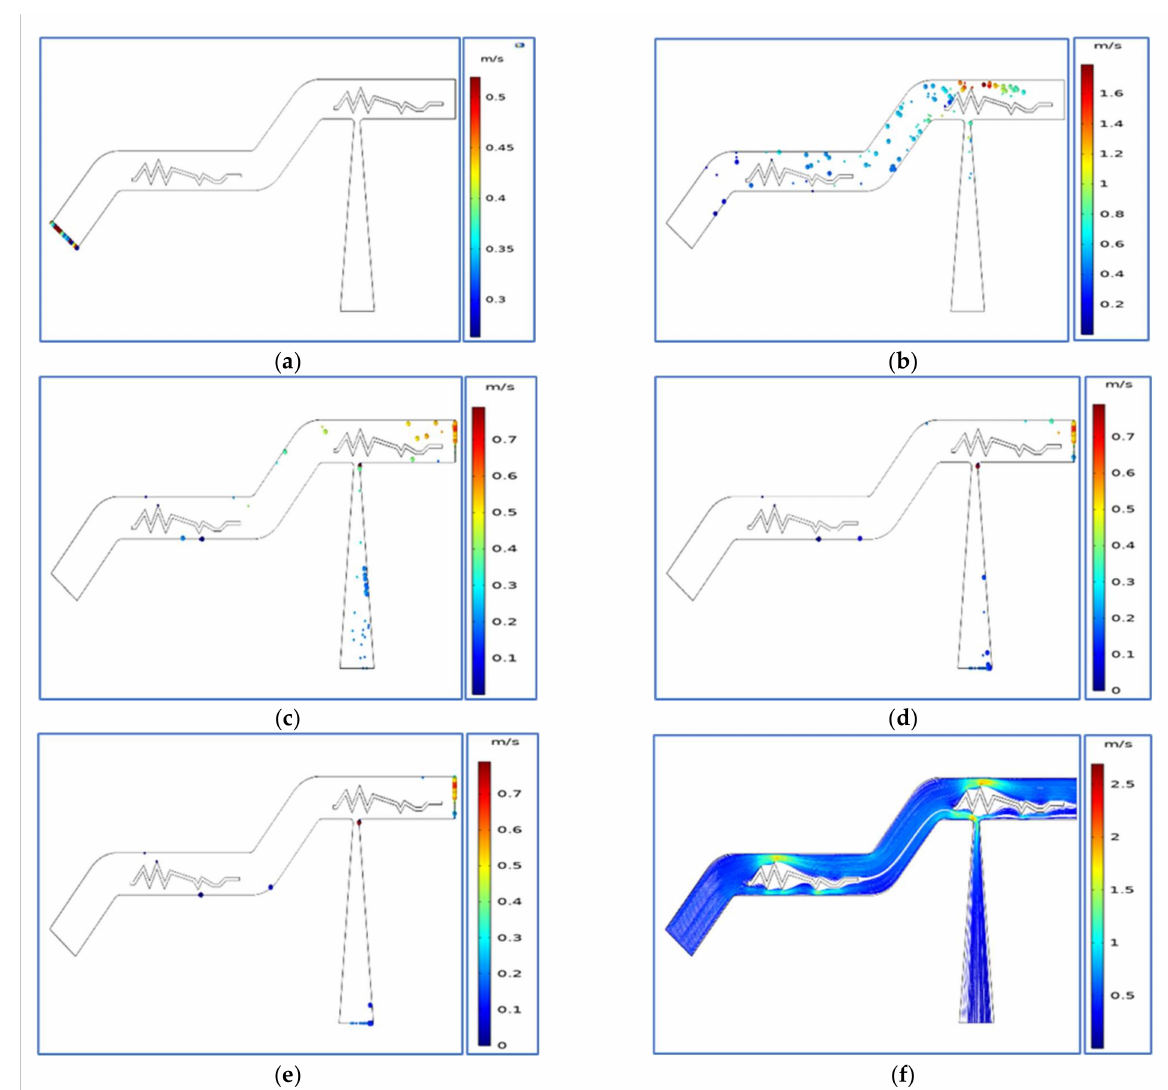
Figure 5. Fluid-particle interaction results of corrugated dragonfly wing microchip at 0–0.04 s and velocity streamline: ( a ) 0 s; ( b ) 0.01 s, ( c ) 0.02 s; ( d ) 0.03 s; ( e ) 0.04 s; ( f ) Velocity streamlines.